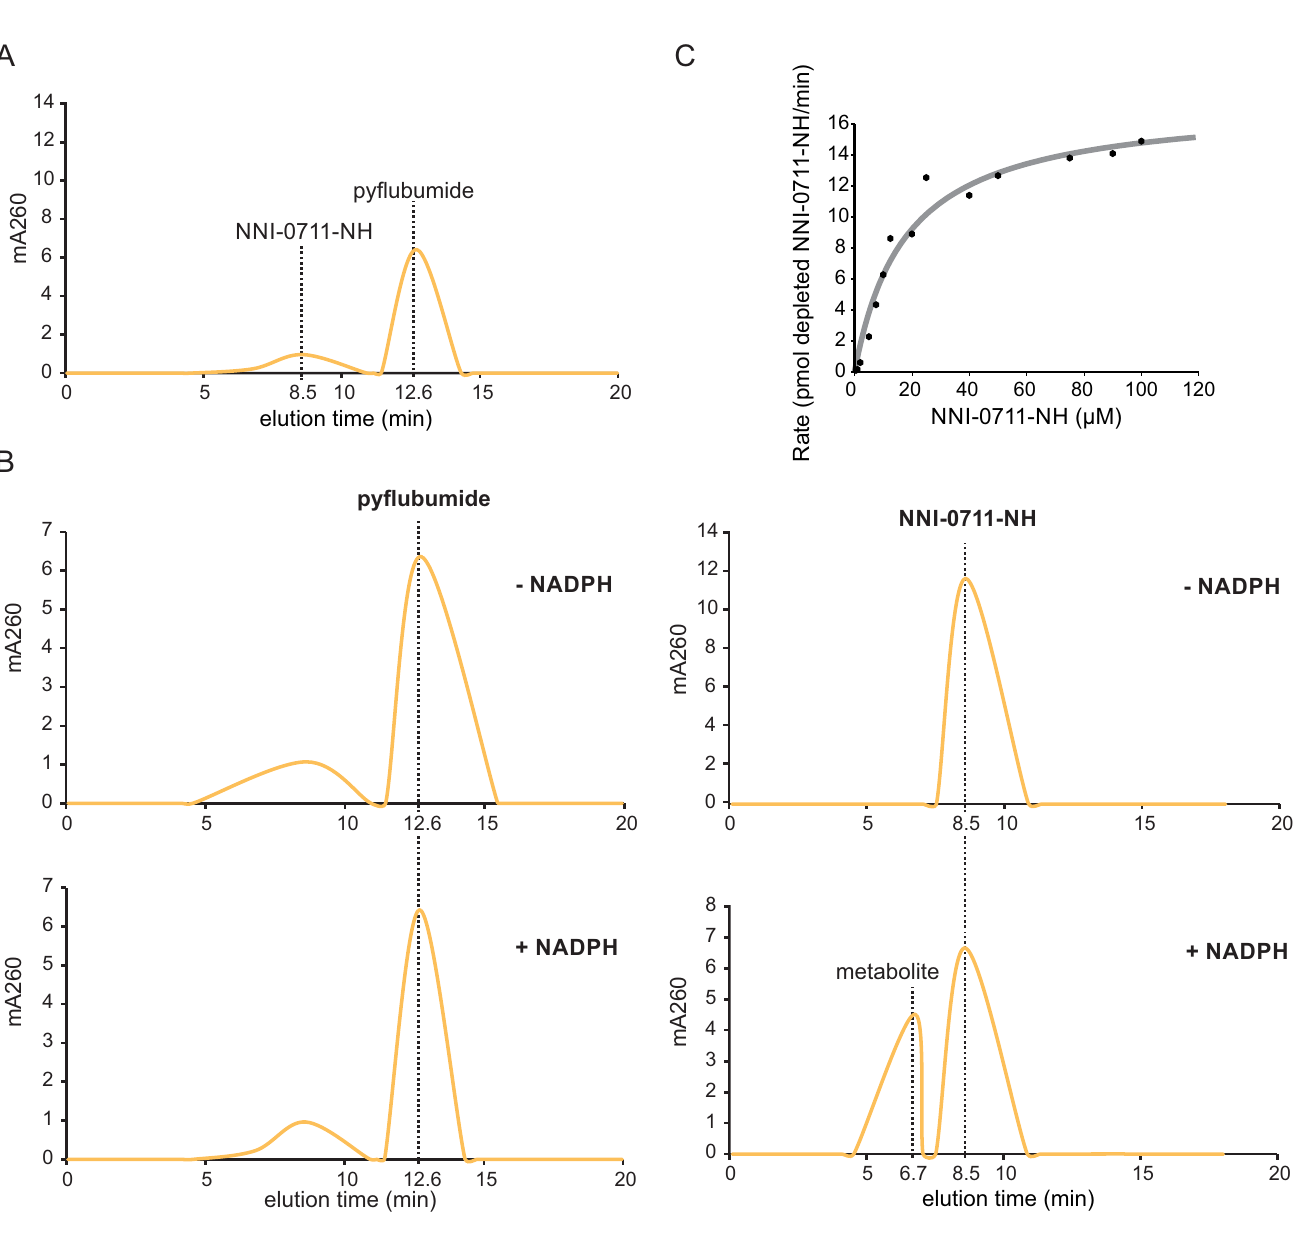
Fig 6. CYP392A16 is active towards the toxic deacylated pyflubumide metabolite, NNI-0711-NH, but not pyflubumide. (A) HPLC chromatogram of pyflubumide and its toxic metabolite NNI-0711-NH, eluting at 12.6 and 8.5 min, respectively. (B) HPLC chromatograms show a NADPH-dependent depletion of the toxic NNI-0711-NH (eluting at 8.5 min) and the corresponding formation of a reaction product (eluting at 6.7 min). In contrast, reactions carried out in the absence and presence of a NADPH-regenerating system showed no change in the chromatogram profile with pyflubumide eluting at 12.6 min. Absorbance curves are plotted in yellow (A and B). (C) Michaelis–Menten kinetics of the depletion of NNI-0711-NH by CYP392A16. Plotted values represent the mean. The curve was calculated by non-linear